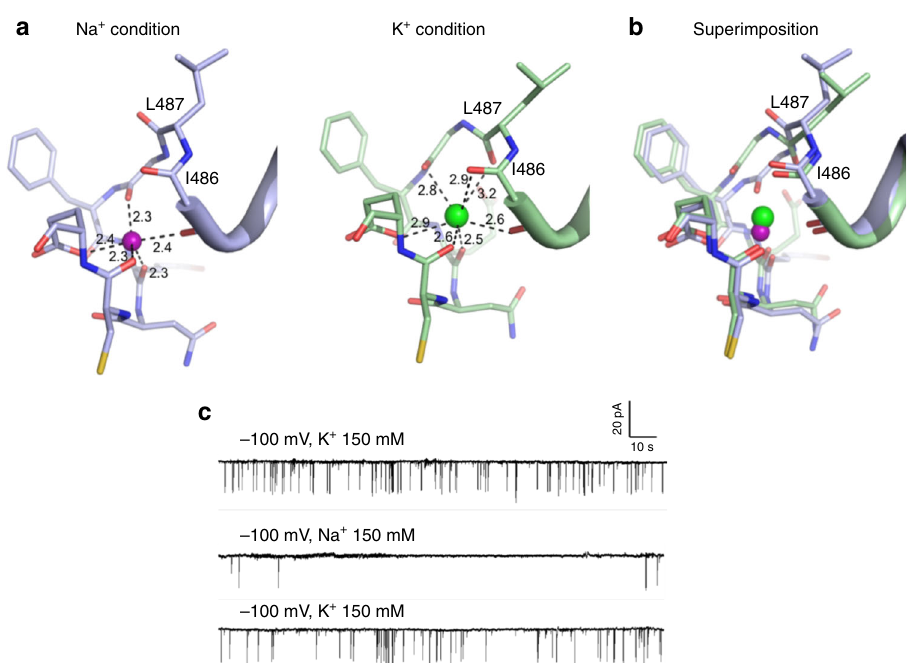
Fig. 5 K + binding at the cluster II Na site. a Structural comparison of the cluster II Na site between Na + -bound (left) and K + -bound (right) structures. Purple and green spheres represent Na + and K + ions, respectively. b Superimposition of the two structures. c Single channel recordings from an inside-out patch with 150 mM [Na + ] in the pipette solution (extracellular) and 150 mM [Na + ] or [K + ] in the bath solution (intracellular). Replacing K + with Na + in the bath solution signi fi cantly reduced the single-channel open probability